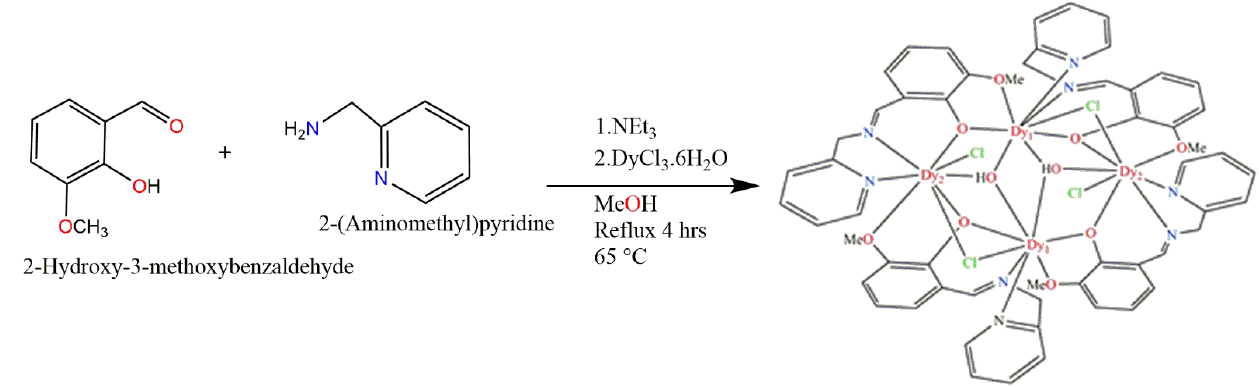
Scheme 1. Schematic representation of the reaction procedure for complex 1 .